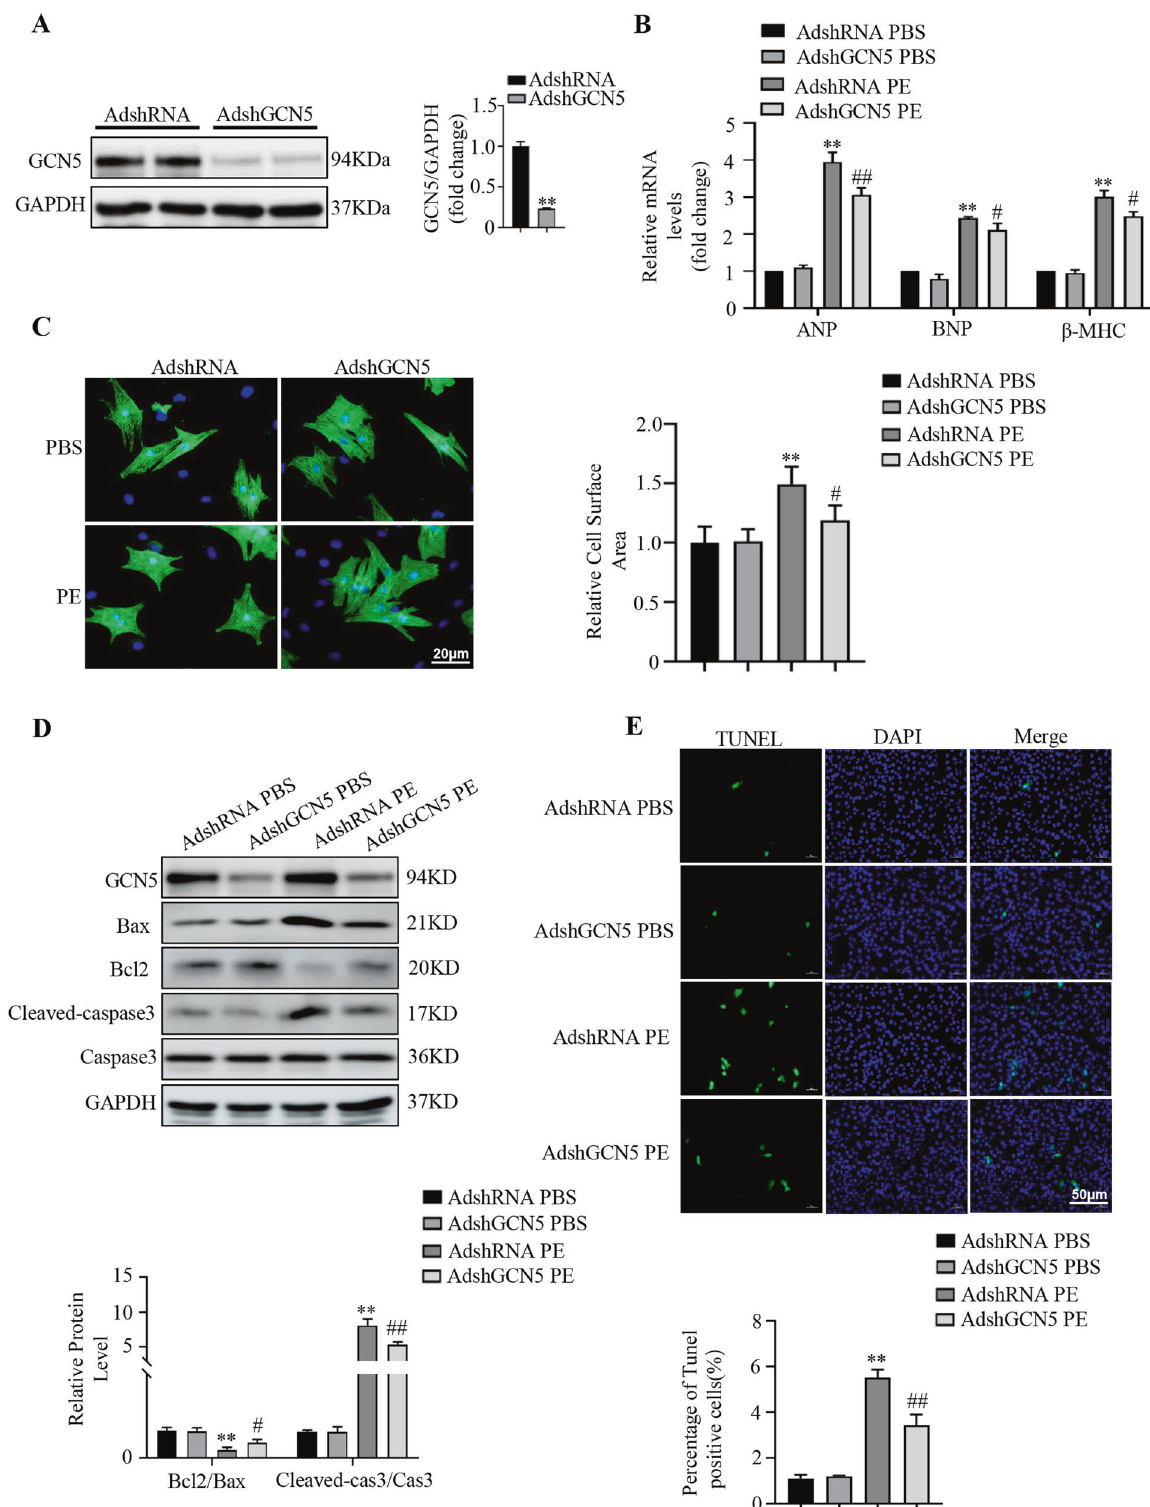
Fig. 4 GCN5 de fi ciency alleviates PE-induced cardiomyocyte hypertrophy and apoptosis. A Immunoblotting of primary cardiomyocytes infected with AdshRNA or AdshGCN5 for 24 h to induce GCN5 expression. B Effects of GCN5 knockdown on the mRNA levels of hypertrophic marker genes. C Effects of GCN5 knockdown on cardiomyocyte surface areas. D Western blots showing that GCN5 knockdown alleviates PE- induced NRCM apoptosis. E Representative images of TUNEL staining, indicating apoptotic rates of NRCMs ( ∗∗ P < 0.01 vs AdshRNA PBS; # P < 0.05 vs AdshRNA PE, ## P < 0.01 vs AdshRNA PE). Data are shown as the mean ± SD from three independent